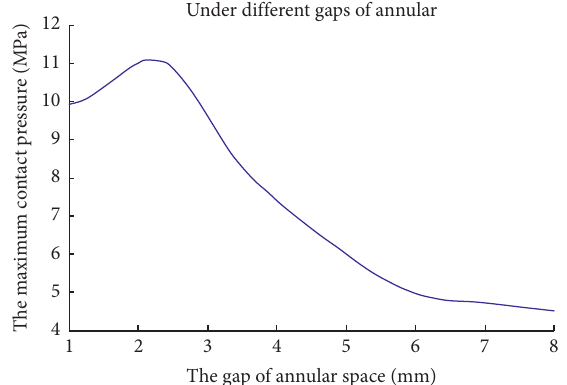
Figure 20: The maximum contact pressure curve of the rubber cylinder under different gaps of